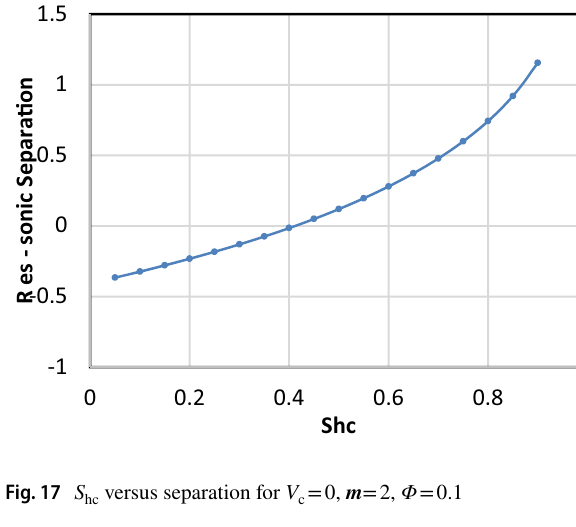
V m = 2, Φ = 0.1 c = 0,